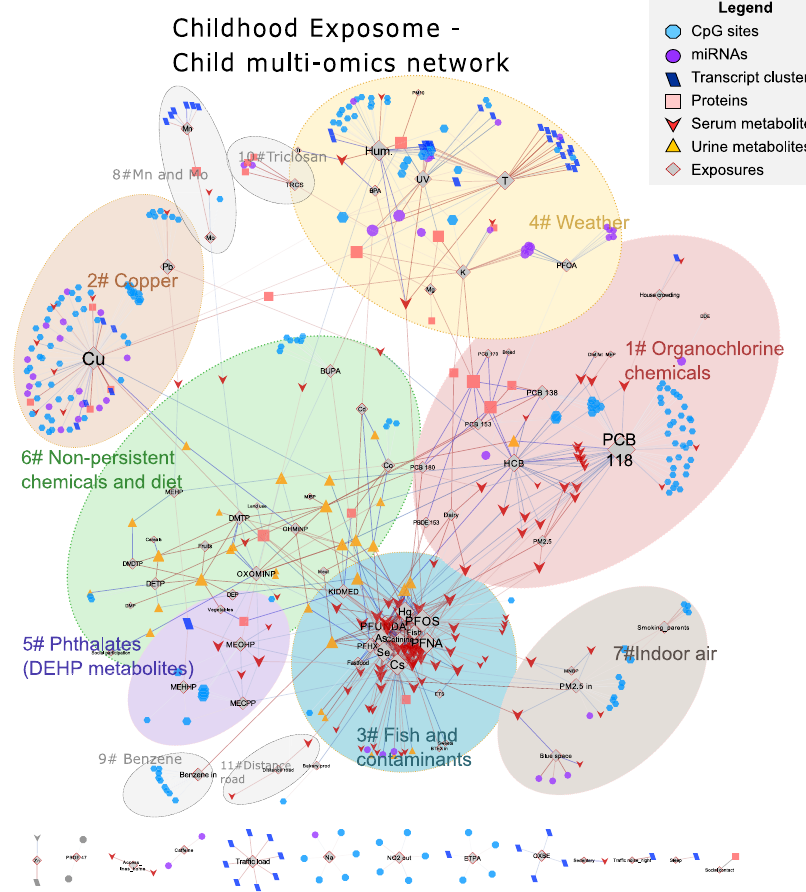
Fig.5|Networkmapofthemulti-omicssignaturesofthechildhoodexposome. Network visualization of the childhood Exposome-omics-Wide Association Study (ExWAS). Nodes of the network are depicted with a different colour/shape depending if they are exposures or features of a particular molecular layer (see legend inthe fi gure).Anexposureandamolecularfeaturewereconnected withan edge if their association was statistically signi fi cant (blue if positively and red